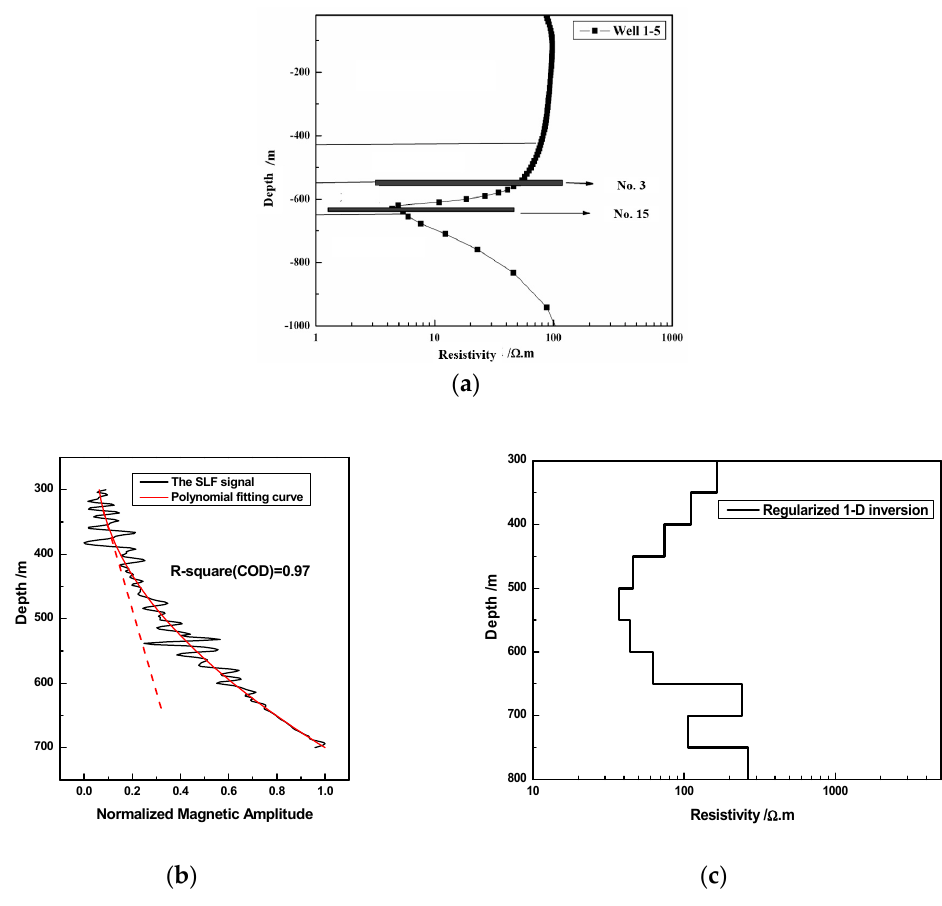
Figure 18. Comparative results of the AMT method and the SLF method regarding the reservoir interpretation of Well 1-5. ( a ) The 3-D inversion results of the AMT method and stratigraphic correlation map; ( b ) Direct depth transformation results of the SLF method. The solid red line in the figure represents the polynomial fitting curve (representing the characteristics of the endogenous field). The red dotted line represents the artificially added trend line, and the bifurcation point with the fitting curve represents the buried depth of the target layer. ( c ) 1-D Regularization inversion curve of the SLF